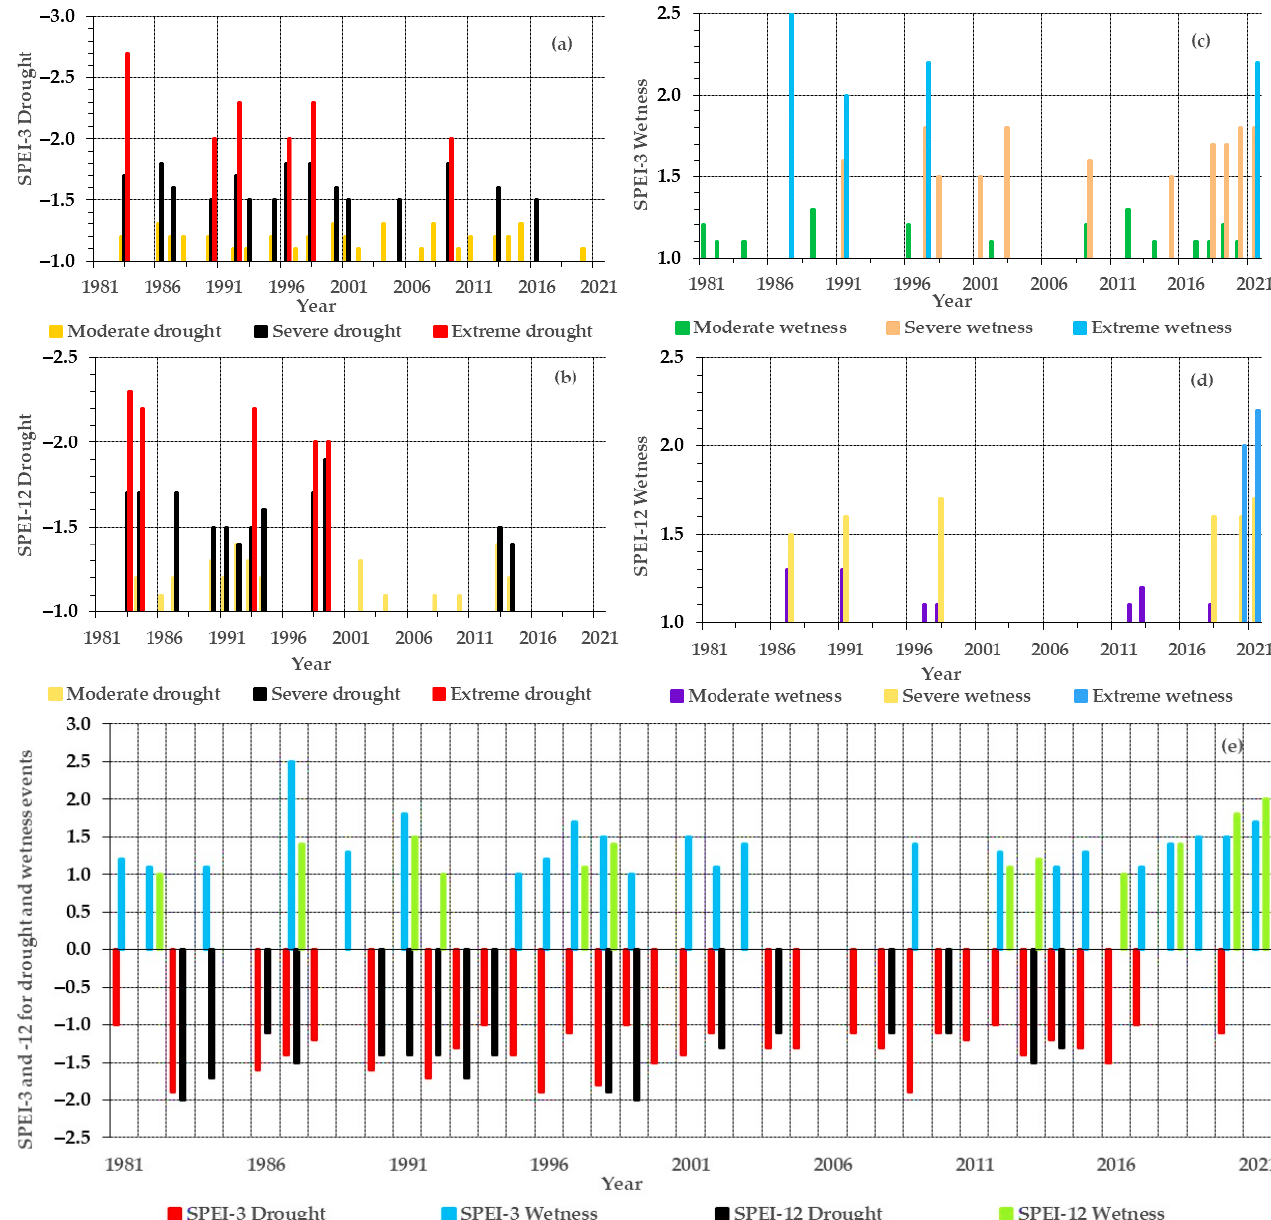
Figure 4. Temporal evolution of the mean annual SPEI-3 and SPEI-12 for moderate-to-extreme drought ( a , b ), wetness ( c , d ), and all drought and wet events ( e ) from 1981 – 2021 over the coastal Savannah agroecological zone in Ghana.